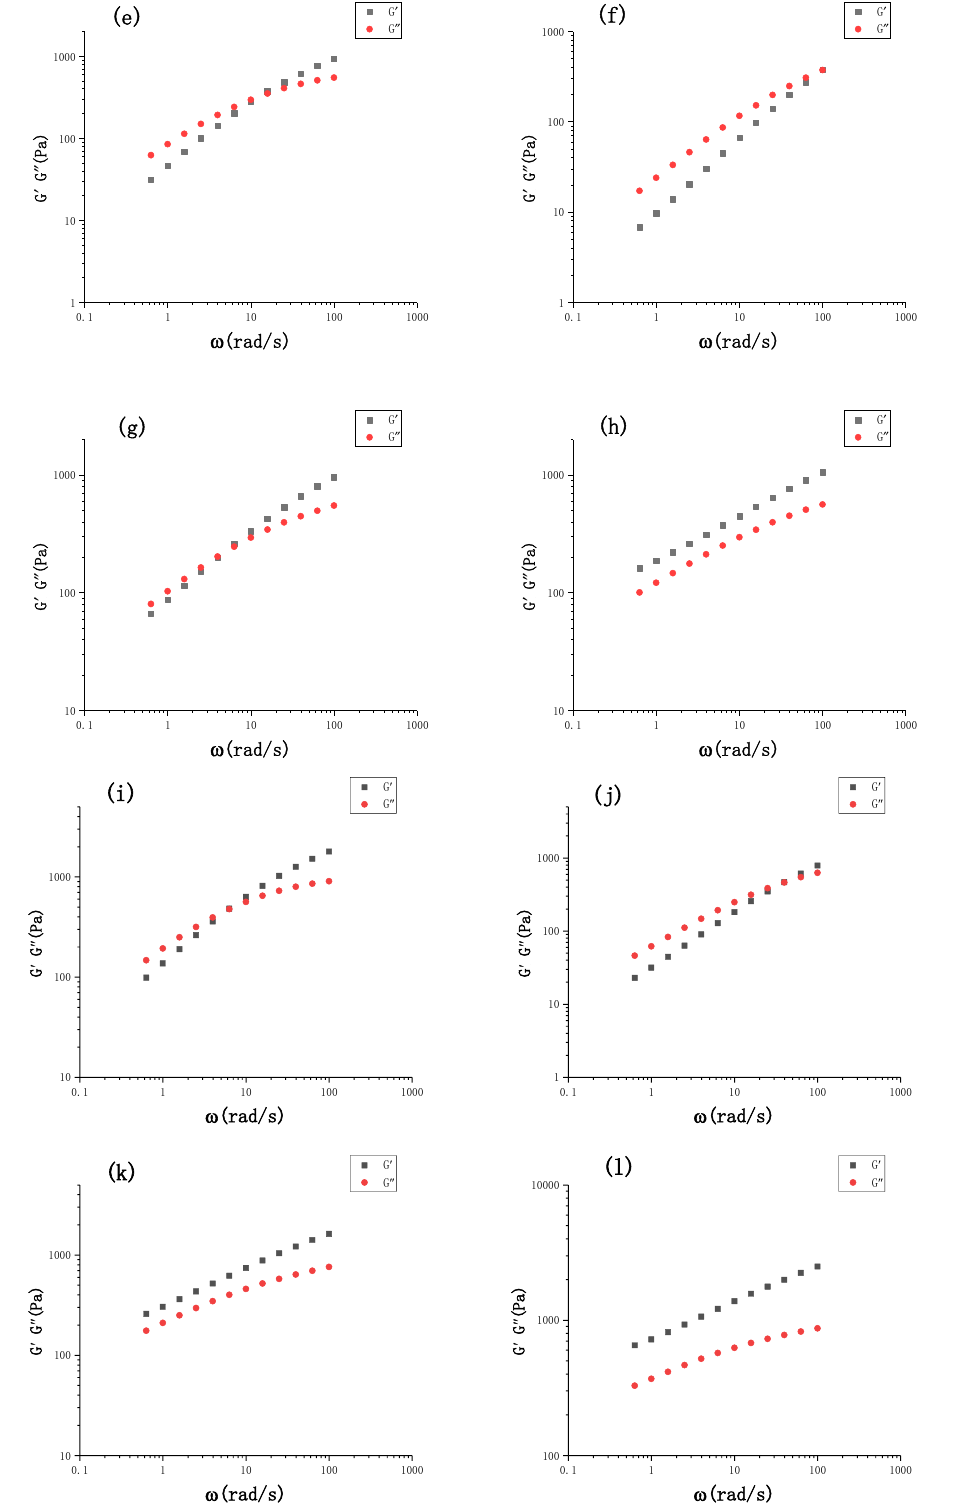
Figure 2. Loss modulus and storage modulus of ( a ) S0-I, ( b ) S1-I, ( c ) S2-I, ( d ) S3-I, ( e ) S0-90, ( f ) S1-90, ( g ) S2-90, ( h ) S3-90, ( i ) S0-30, ( j ) S1-30, ( k ) S2-30, ( l ) S3-30. Note: I, 90 and 30 represent the initial water content, 90% water content and 30% water content of the film-forming solutions, respectively. The following legends are the same.